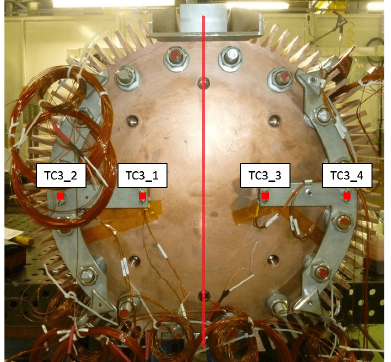
FIG. 22. Positions and labels of the four thermocouples that are placed on the upstream face of the dump core. The vertical red line corresponds to the projection of the symmetry plane that was implemented in the FEM simulations.